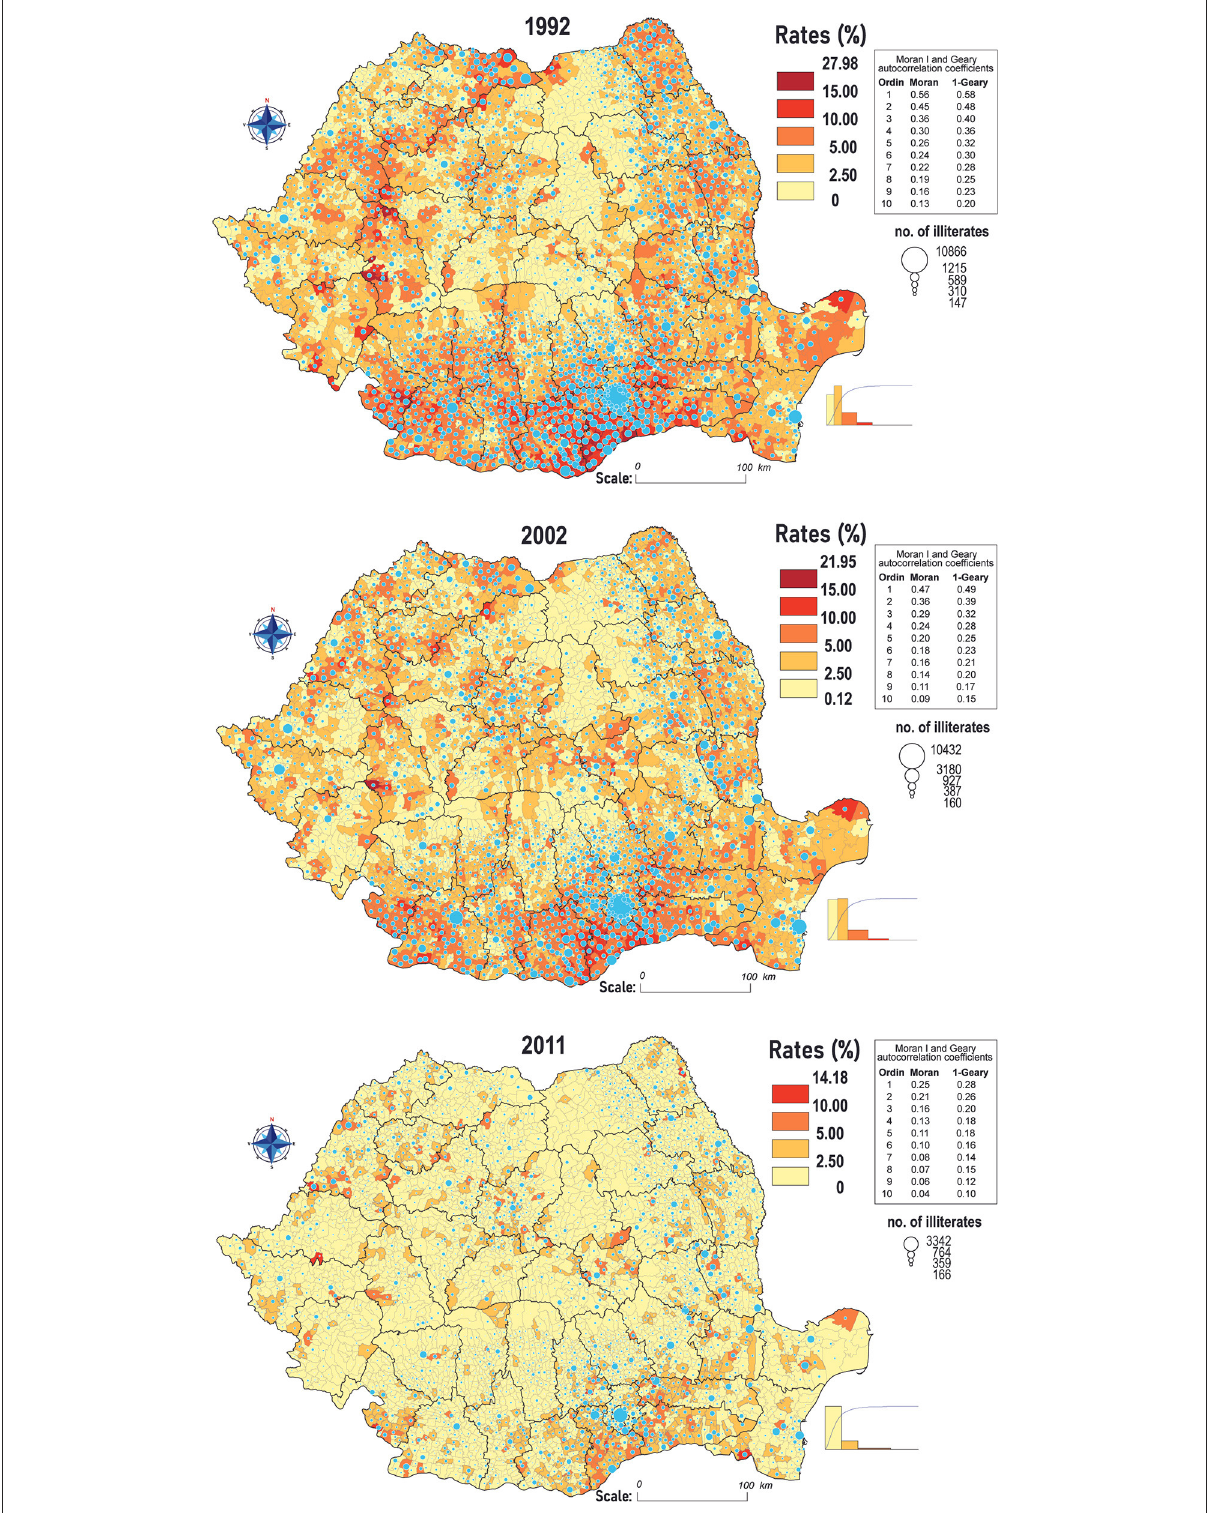
FIGURE1 Spatial distribution of illiteracy rates according to the 1992, 2002 and 2011